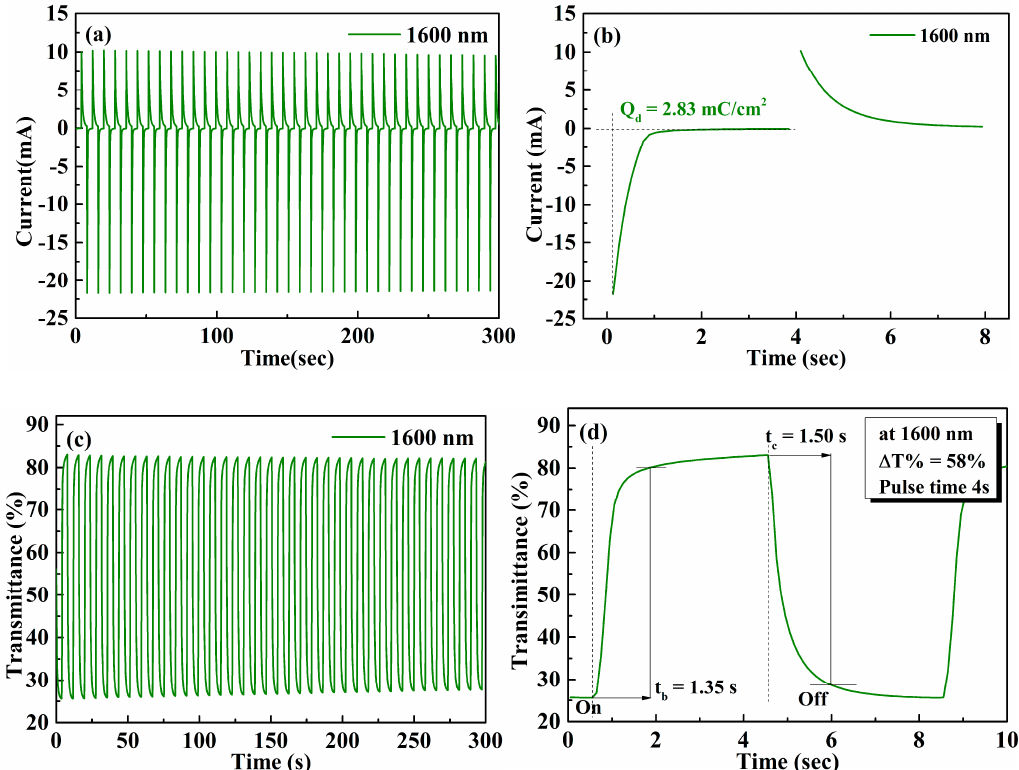
Figure 7. ( a ) Current–time switching curve of PITID-2 film between 0 and 1.35 V in a time interval of 4 s. ( b ) The second cycle of current–time curve. ( c ) Transmittance–time curve of PITID-2 last for 300 s at 675 nm. ( d ) The bleaching time ( t b ) and the coloration time ( t c ) of PITID-2 at 1600 nm.